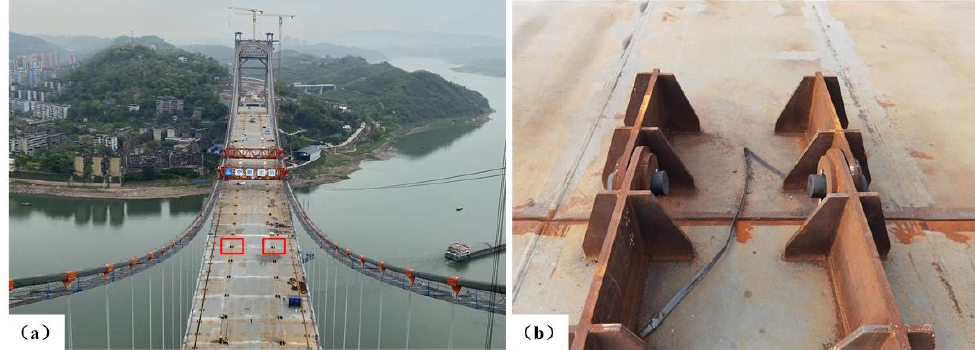
Figure 5. Stiffness beam hinge joint method of the Guojiatuo Suspension Bridge. The red box in ( a ) shows the connection component; ( b ) shows the enlarged details of the connection component between two stiffness beam.